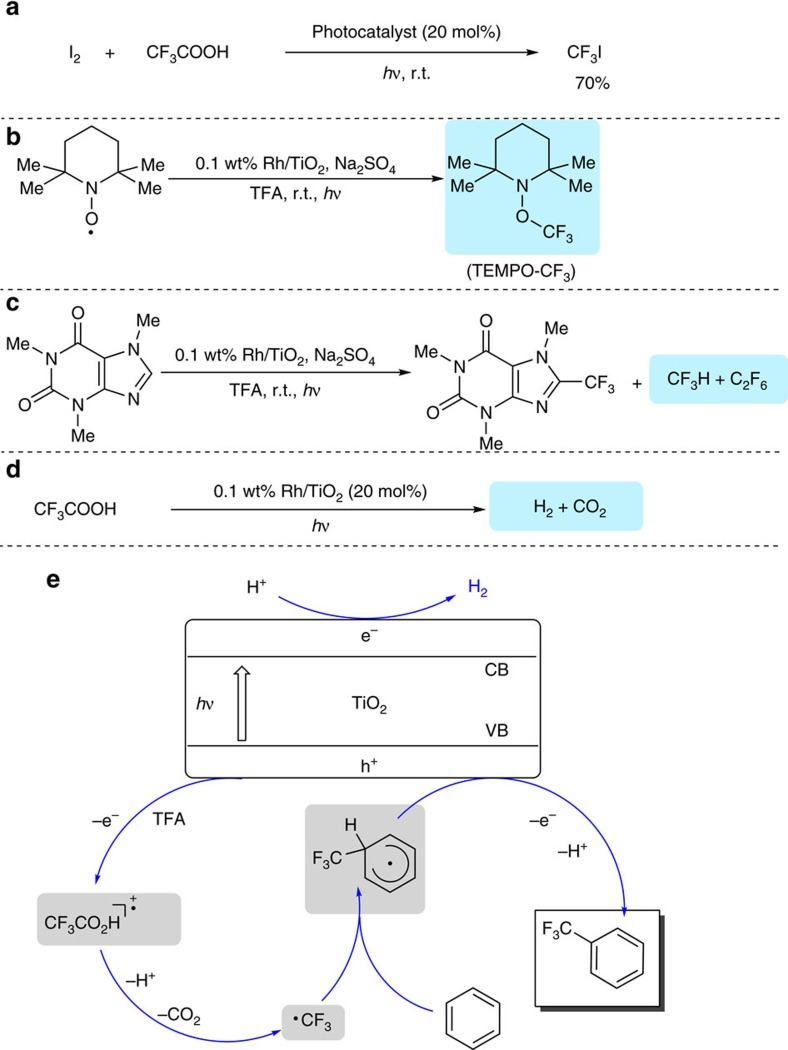
Mechanism studies.(a) Synthesis of CF3I via decarboxylative coupling of I2 with TFA. (b) Capture of CF3 radical by TEMPO. (c) Determination of CF3H and C2F6 side products in trifluoromethylation of caffeine. (d) Determination of H2 and CO2 from the photo-driven decarboxylation of TFA. (e) The proposed reaction mechanism.